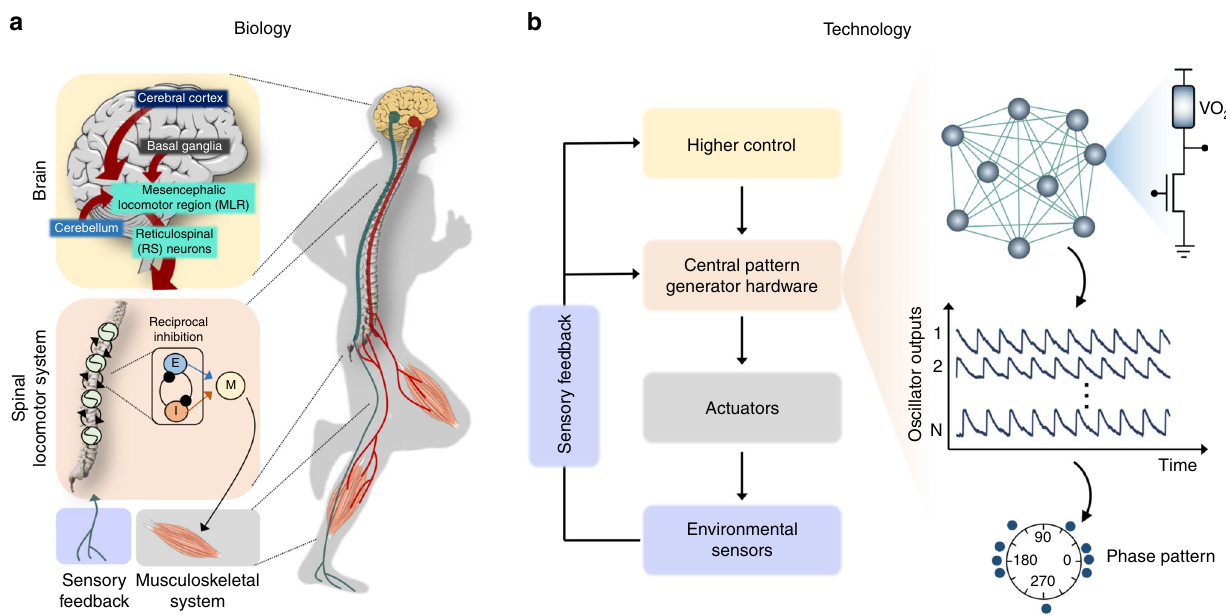
Fig. 1 Central pattern generator (CPG)-based locomotion control. a Illustration of the signal fl ow involved during locomotion in a human. b Overview of bio- inspired CPG-based robotic locomotion control. The proposed CPG hardware implementation is based on coupled insulator-to-metal phase-transition nano-oscillators accompanied by orders of magnitude abrupt change in resistiv- a ring con fi guration with bidirectional nearest-neighbor coupling. ity 40 . The phase transition is hysteretic in nature, meaning that the IMT transition and the MIT transition do not occur at the oscillators are capacitively coupled using off-chip capacitors, C C = 200 nF (see Method and Supplementary Fig. 1 for full experi- same voltage. Figure 2a shows a false-colored tilted view scanning electron microscope (SEM) image of the fabricated two-terminal VO 2 device used in our experiments (see Methods for details) along with the hysteretic direct current current – voltage char- acteristics of the device (Fig. 2b). The device dimensions used for = 200 nm and W = 100 nm – 2 μ m. measurements were L VO 2 VO 2